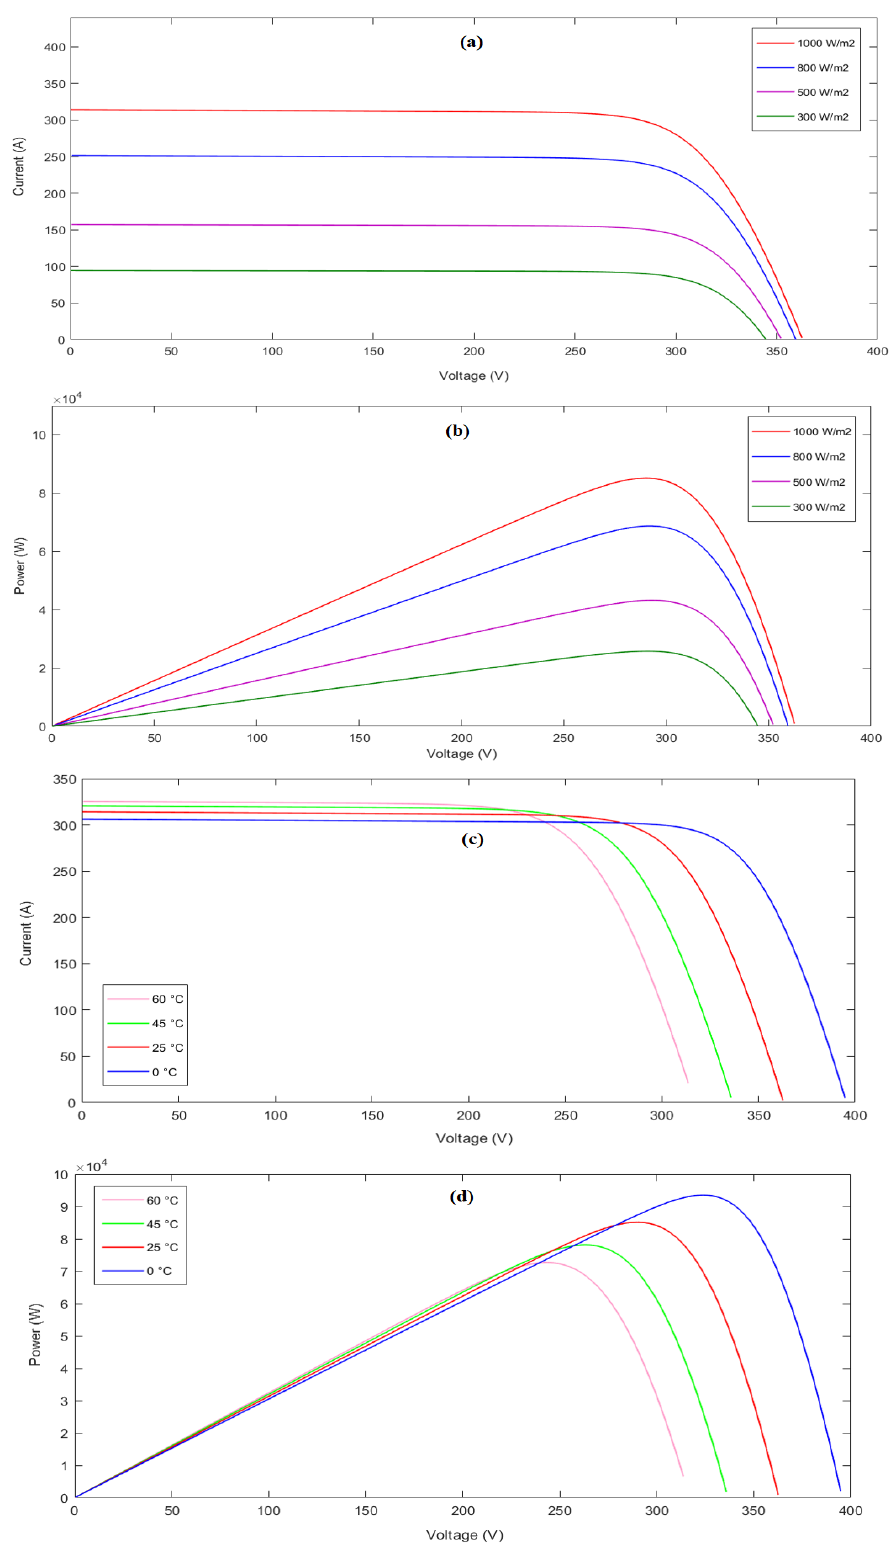
Figure 3. Different irradiance and temperature values on characteristic curves. ( a ) Current–voltage graph in different irradiance; ( b ) Power–voltage graph in different irradiance; ( c ) Current–voltage graph in different temperatures; ( d ) Power – voltage graph in different temperatures.